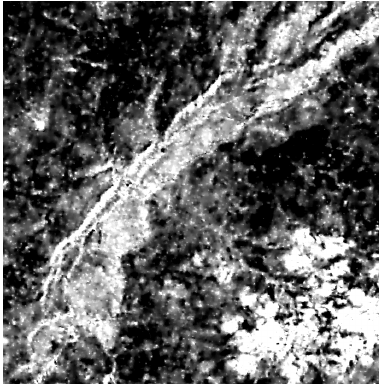
Figure 10. Bragg effect in ERS-2 data (1998-11-20). The water in the end of the rainy season has a very high backscatter